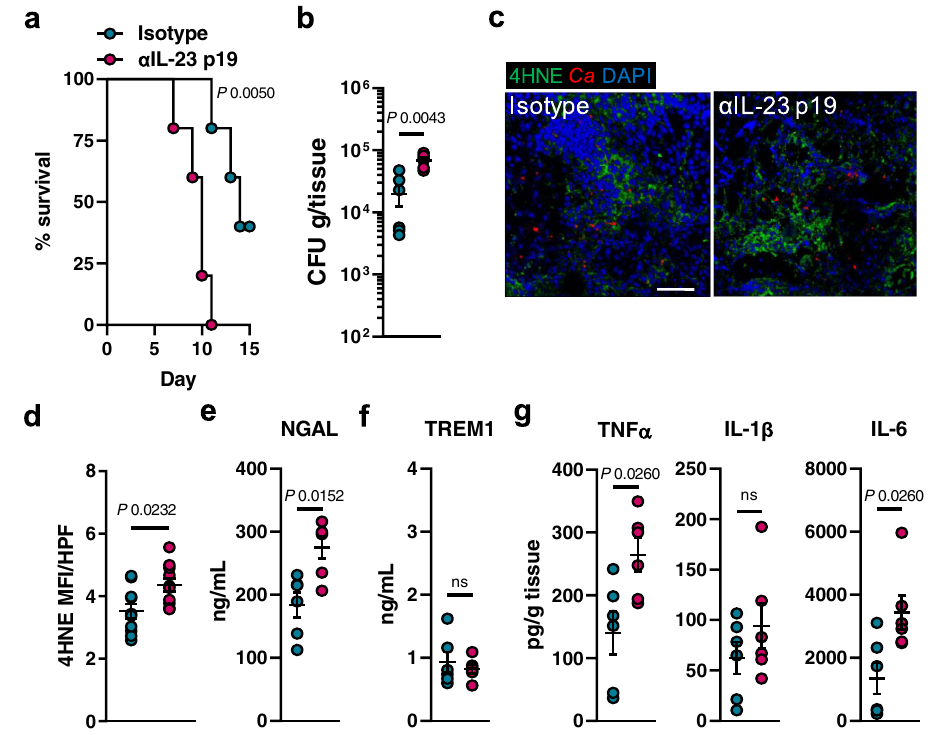
Fig. 9 | IL-23 depletion in Epha2 – / – mice increases ferroptosis and worsens dis- ease severity. a Survival of wild-type mice infected intravenously with 2.5×10 5 SC5314 C. albicans . N =5; combined data of two independent experiments. Mantel – CoxLog-Ranktest. b Renalfungalburdenafter3daysofinfection. N =6for each group; combined data of two independent experiments. Two-tailed Mann – Whitney Test. c , d Lipid peroxidation in infected kidneys after 3 days of infection using 4HNE. 4HNE shown in green, C. albicans ( Ca ) in red. Tissue is